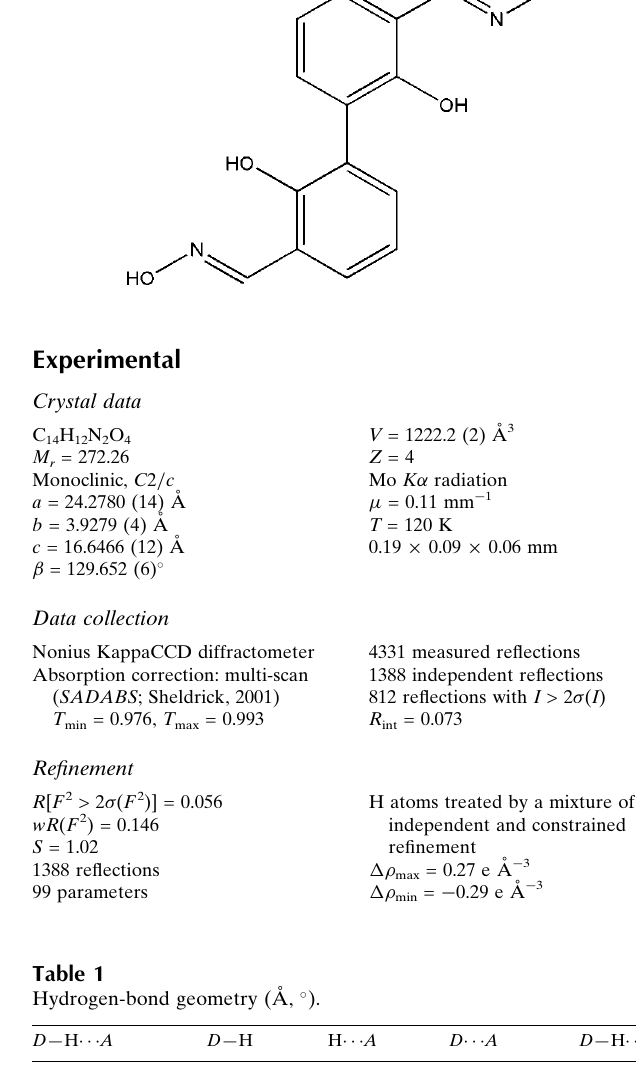
Experimental Crystal data